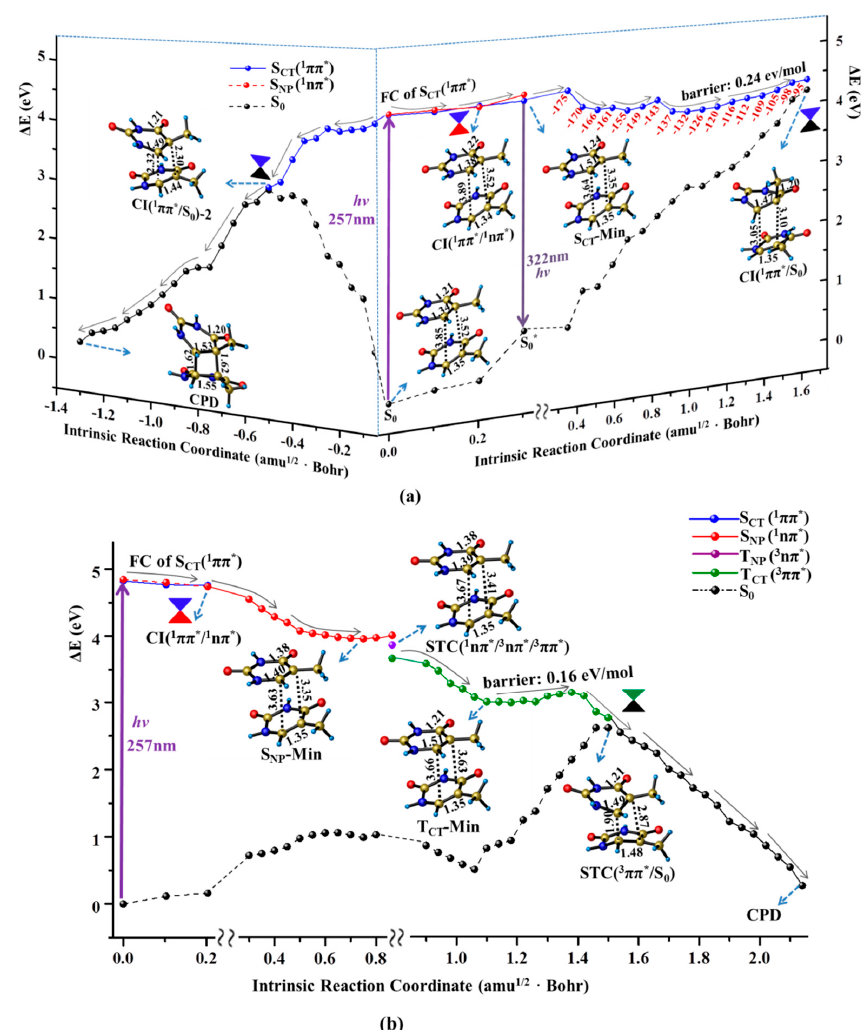
Figure 3. MEPs of three competitive deactivation paths for the thymine oligomer in DNA photo-initiated by 257 nm light in the bright S CT ( 1 ππ *) ( a ) and T CT ( 3 ππ *) state ( b ), obtained at the CASPT2//IRC//CASSCF(14e/11o)/Amber QM/MM level of theory. Schematic structures are shown with the selected bond lengths (in Å) and the changes of N1C4C5C7 dihedral angle are given along the singlet sate relaxation path (the red numbers in degree).